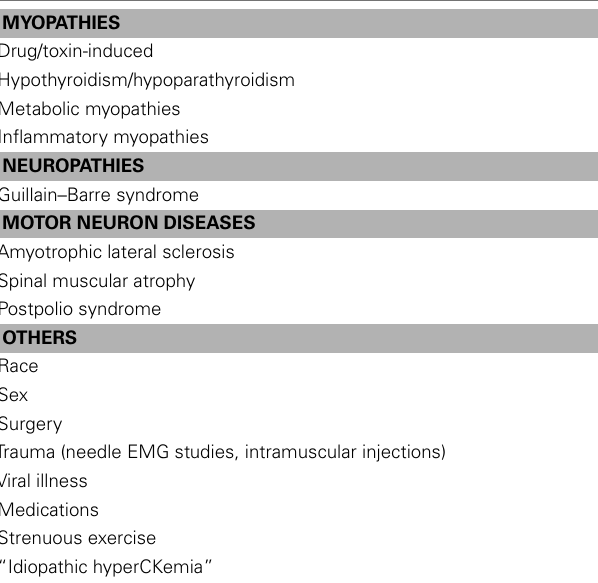
Table 7 | Differential diagnosis of acquired causes of creatine kinase elevation.